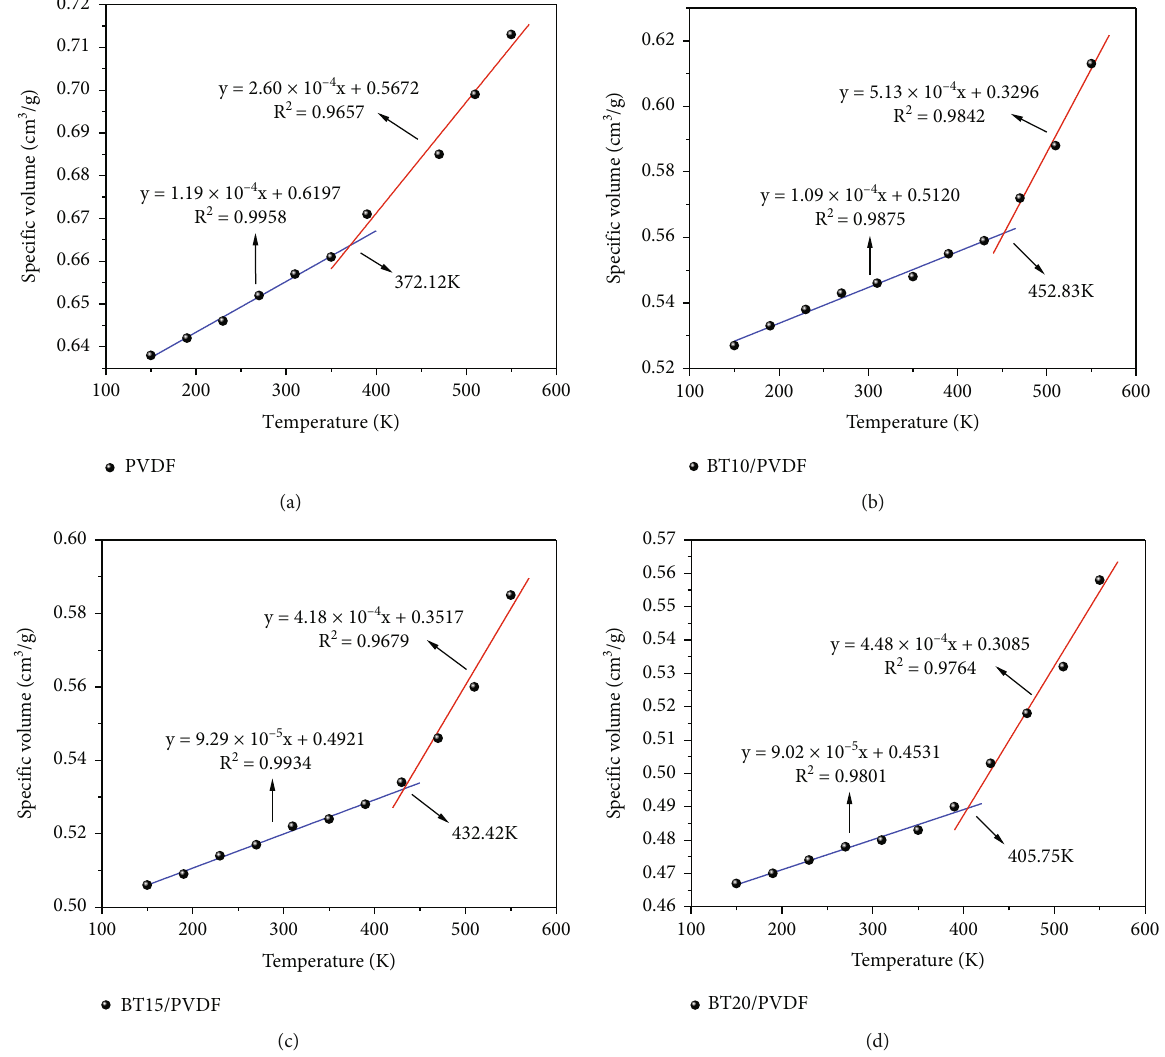
Figure 9: The speci fi c volume vs. temperature curves of PVDF (a), BT10/PVDF (b), BT15/PVDF (c), and BT20/PVDF (d) by MD